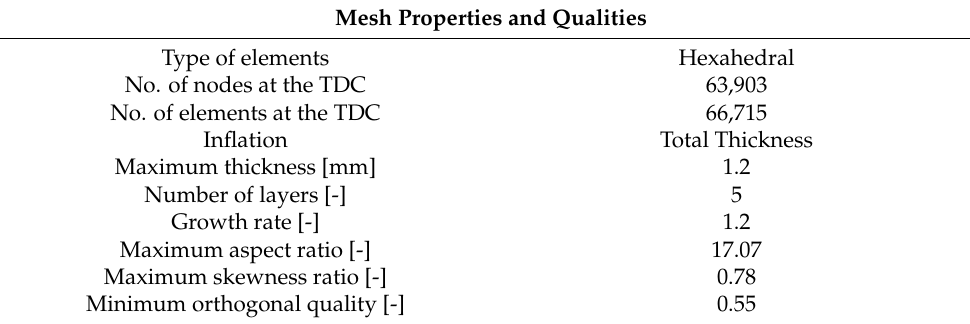
Figure 2. One-third portion of the 3D computational mesh of the engine combustion chamber at the TDC. Table 2. Mesh properties and qualities.